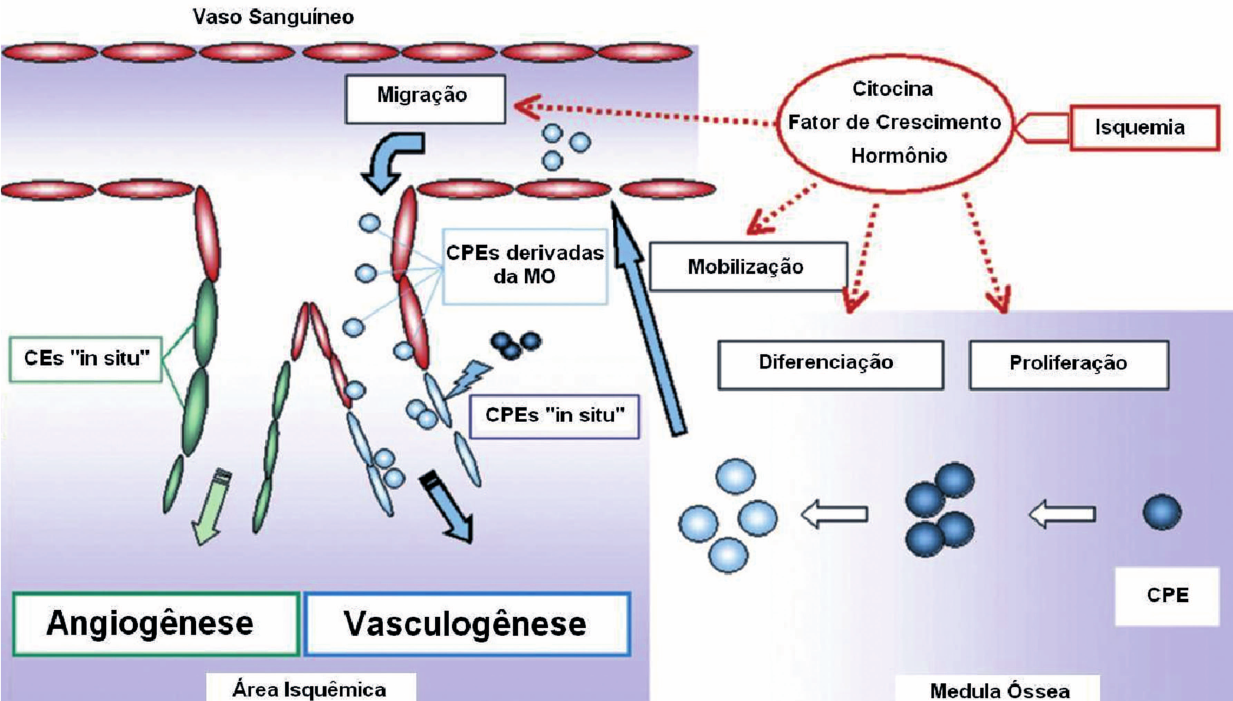
Fig. 1 – Sequência de eventos no processo da angiogênese